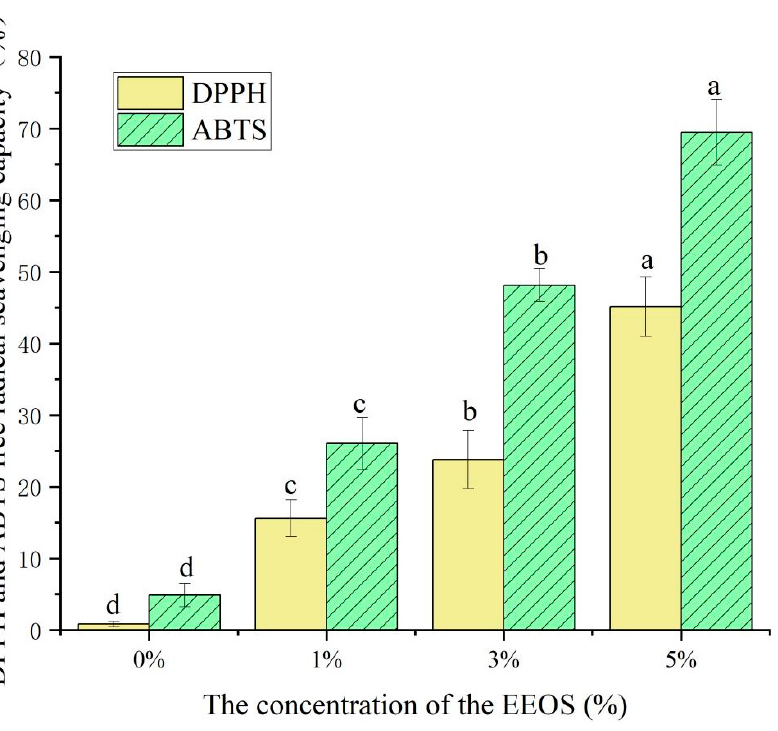
Figure 8. Scavenging activities of the CS/ κ C, CS/ к C/EEOS I, CS/ к C/EEOS II, and CS/ к C/EEOS III composite films on DPPH and ABTS radicals. a–d Values are given as means ± standard deviation. Different letters in the same line indicate significant difference ( p < 0.05).